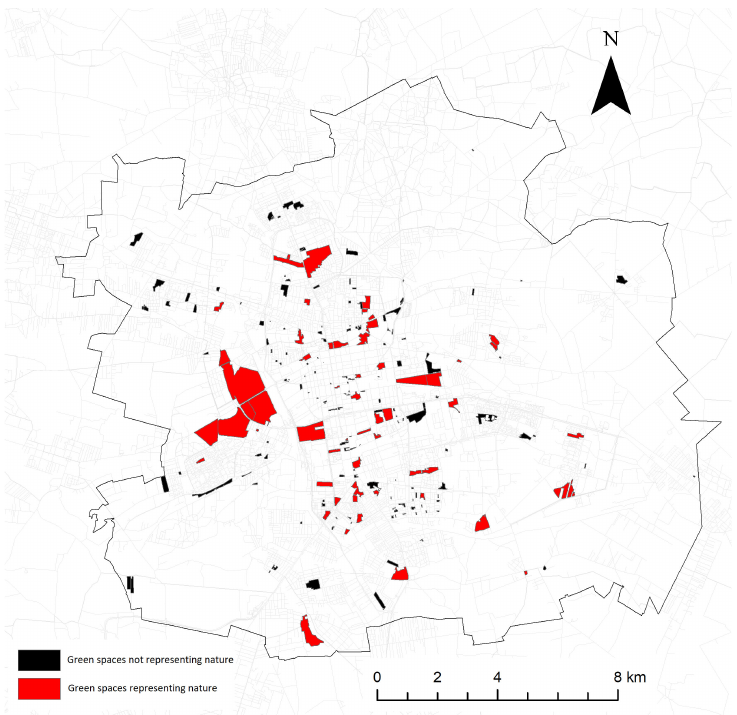
Figure 5. Urban green spaces in Lodz representing the “nature” sociotope